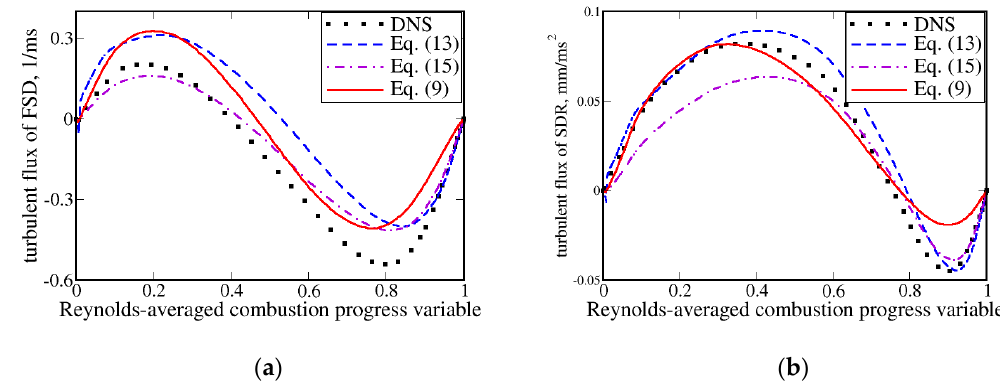
Figure 5. Turbulent axial fluxes of ( a ) FSD Σ and ( b ) SDR χ . Case M.